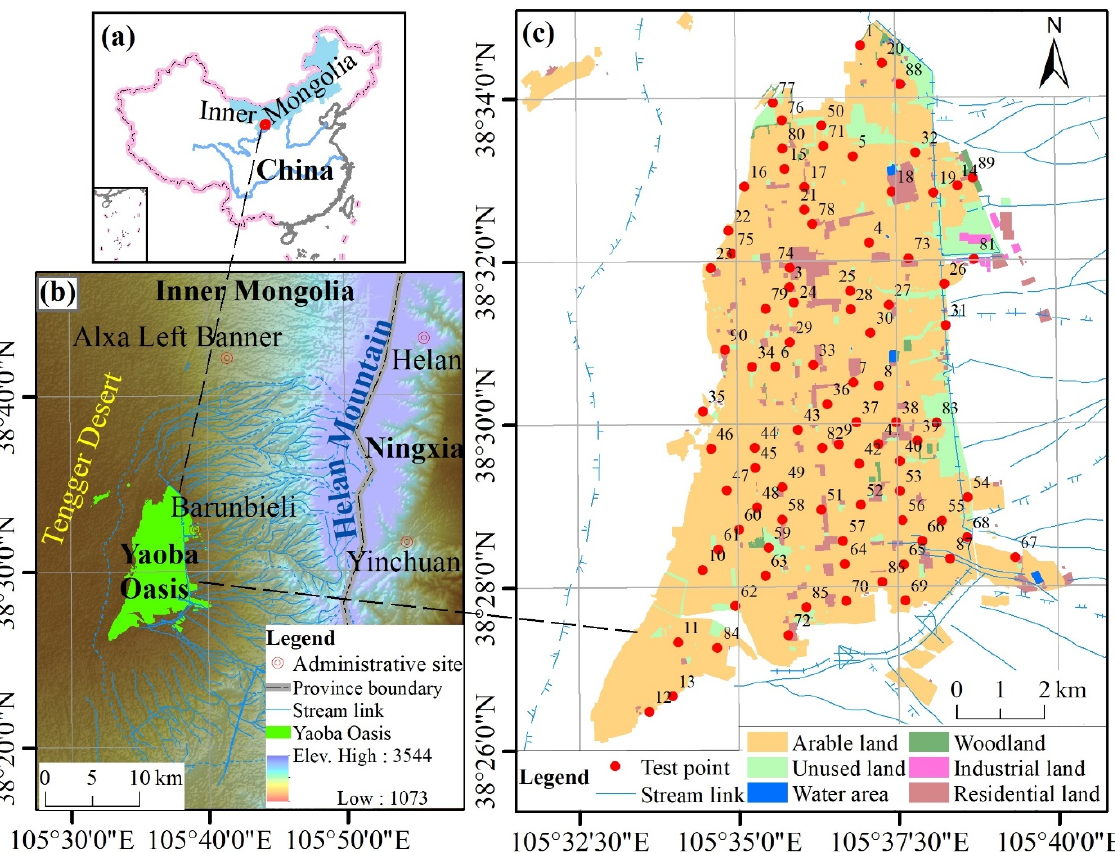
Figure 1. Map of the study region: ( a ) Yaoba Oasis in China; ( b ) Yaoba Oasis in Alxa Left Banner, Inner Mongolia Autonomous Region; and ( c ) land use in Yaoba Oasis and water sampling wells.